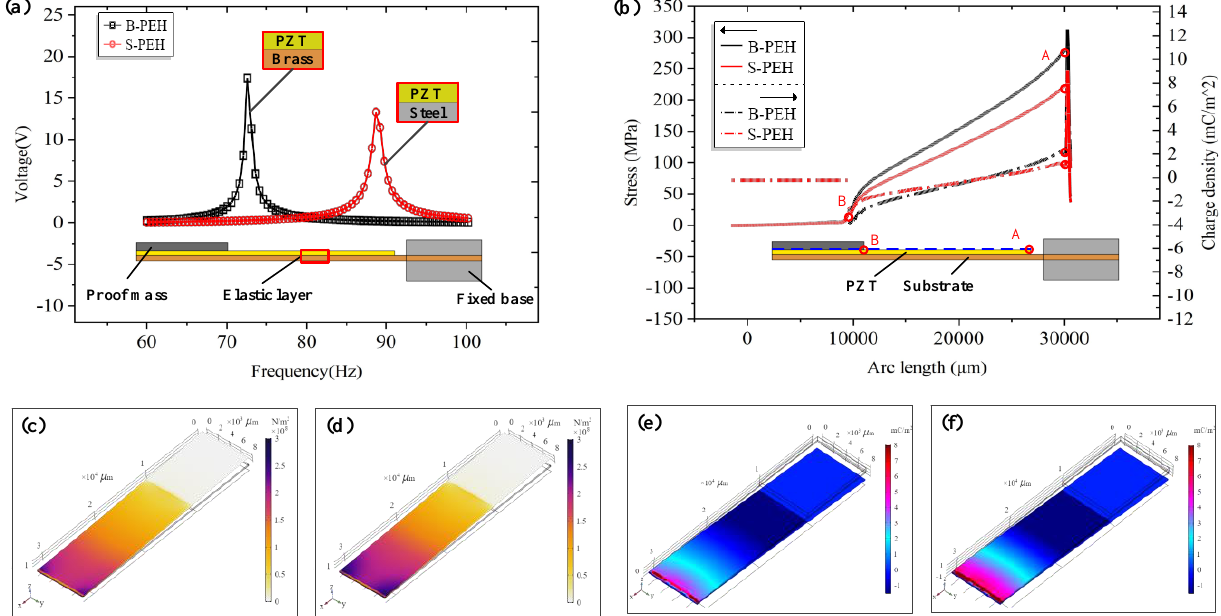
Figure 2. ( a ) Voltage output of S-PEH and B-PEH at different frequencies. ( b ) The stress level and charge density on the outside of the piezoelectric layer. ( c ) Surface stress distribution of S-PEH. ( d ) Surface stress distribution of B-PEH. ( e ) Surface charge density of S-PEH. ( f ) Surface charge density of B-PEH.